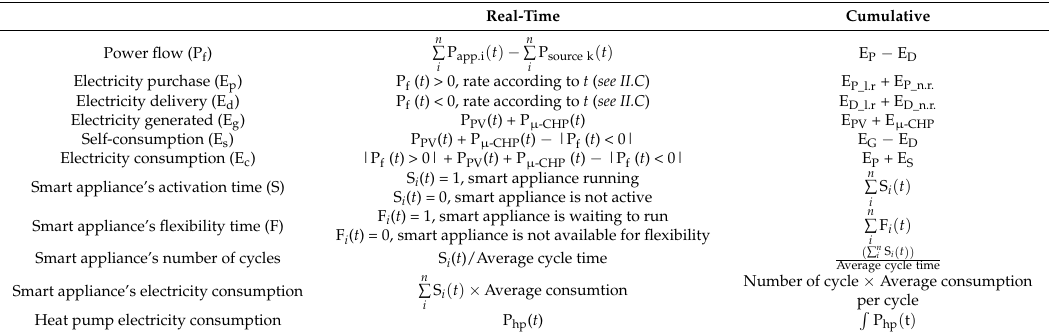
Table 3. Energy indicators and equations used to determine them; E, energy; P, power; t, time; n, number of appliances; m, number of energy sources; n.r., normal rate; l.r., low rate; S, logical array of activation time; and F, logical array of flexibility time. Real-Time